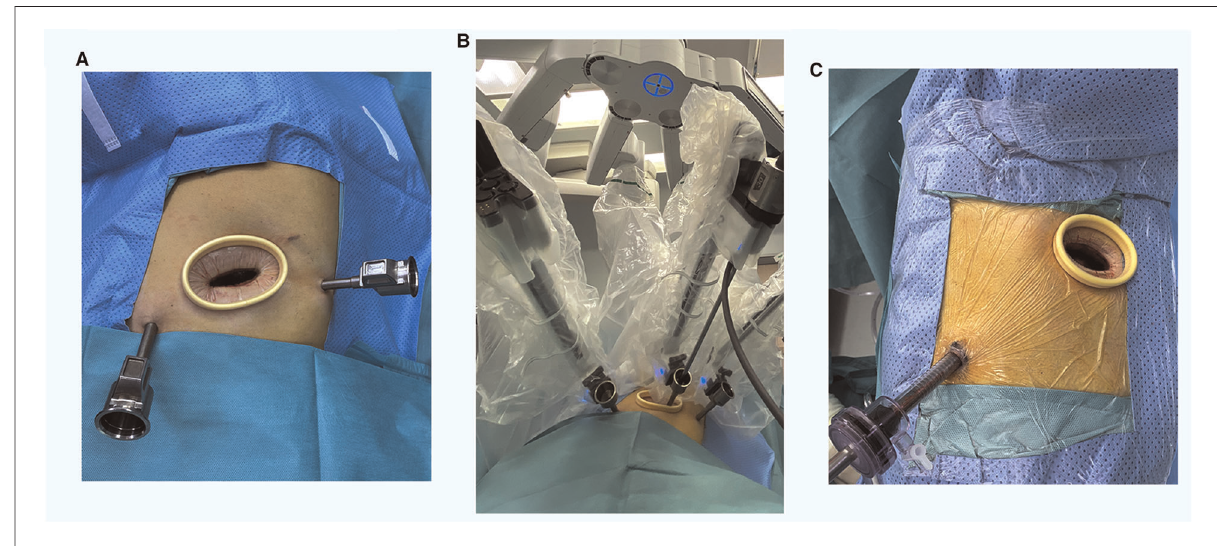
FIGURE 1 The incisions and ports placement of RATS ( A,B ) and VATS ( C ). RATS, robotic-assisted thoracoscopic surgery; VATS, video-assisted thoracoscopic